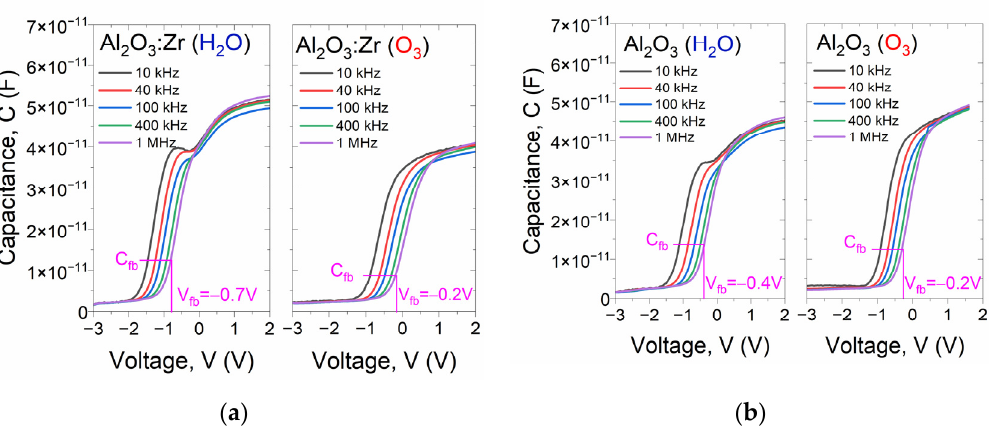
Figure 6. The typical family of high-frequency C-V characteristics of MIS structure with 20 nm ALD gate dielectric film investigated in this work: ( a ) Al 2 O 3 and ( b ) Al 2 O 3 :Zr.